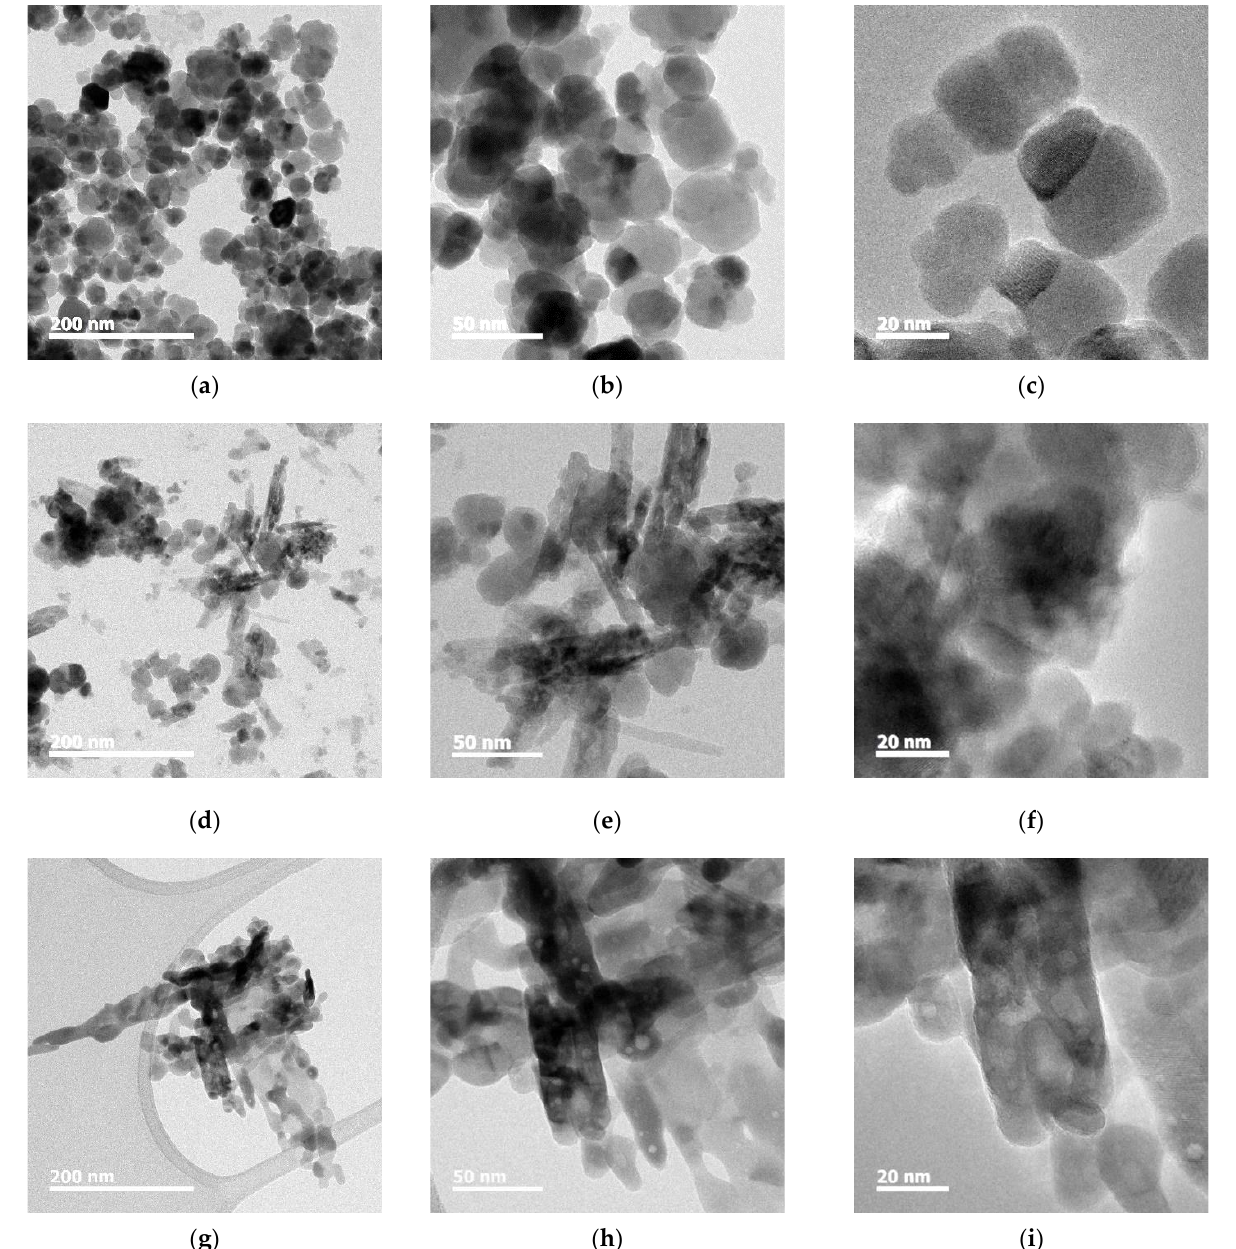
Figure 6. HRTEM observations of FeO x NPs with ( a – c ) 0 wt%; ( d – f ) 1 wt%; ( g – i ) 2 wt%.